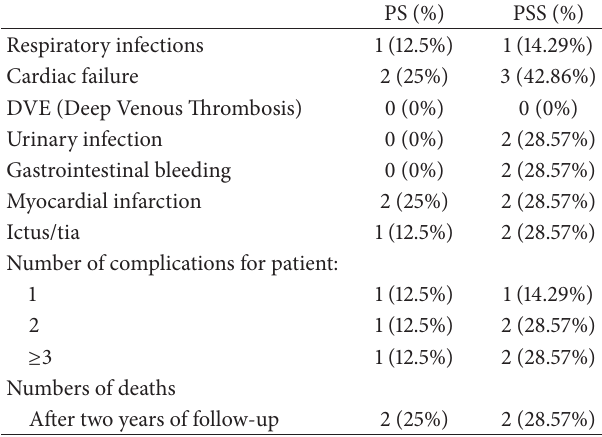
Table 3: Postoperative complications during all the